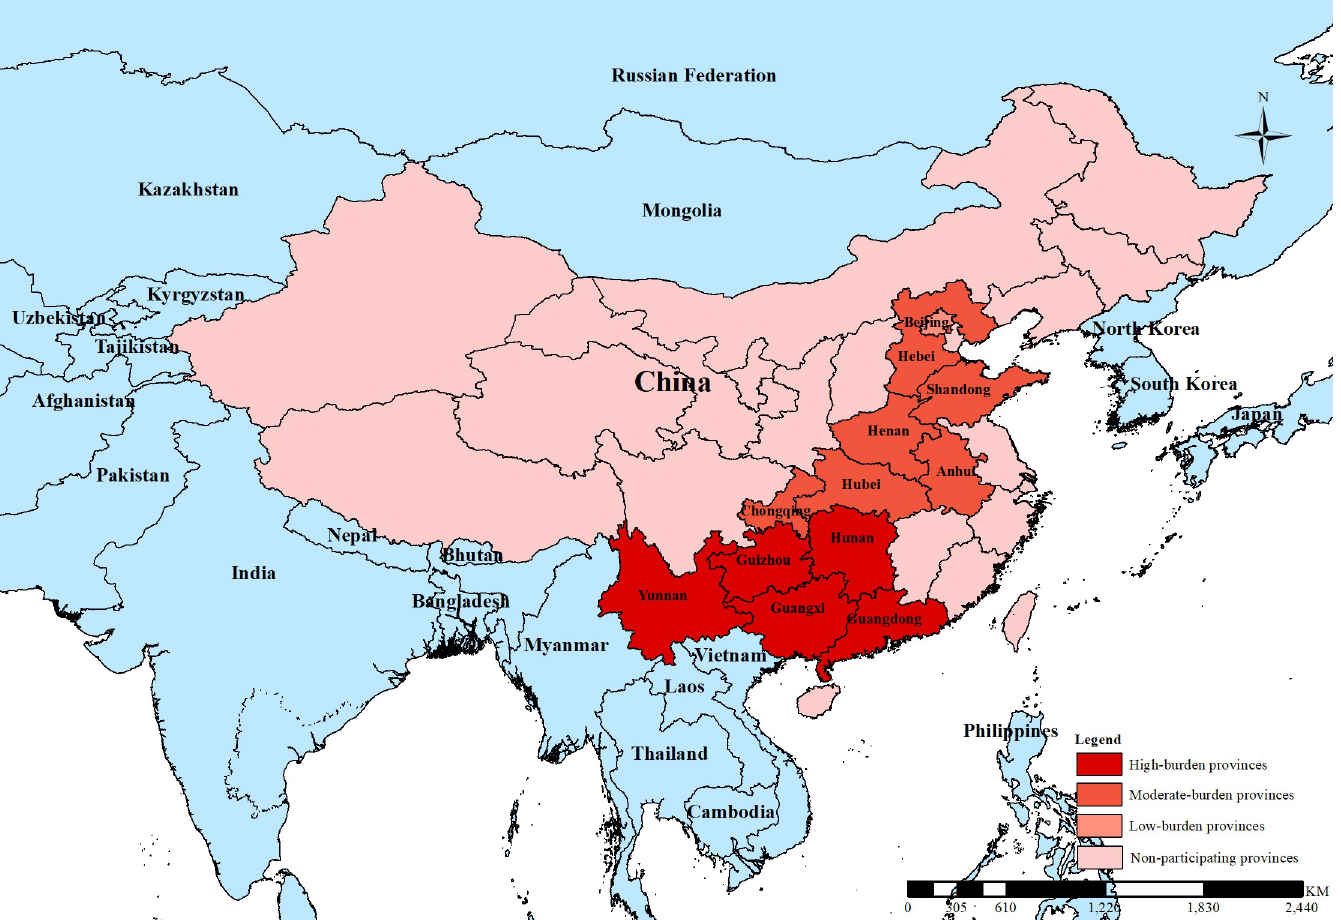
Fig 1. Location of the 12 provinces participating in the SARE Workshop by dog-mediated rabies burden, March 2019, China. (Note: China CDC and China Animal CDC offices are located in Beijing. SARE referred to Stepwise Approach towards Rabies Elimination).